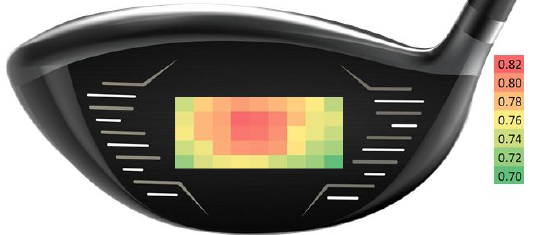
Figure 1. COR map overlaid across a driver